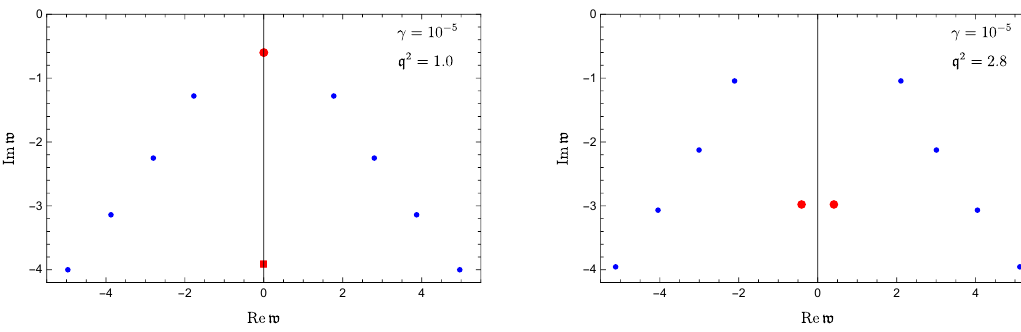
Figure 2 . Quasinormal spectrum in the shear channel of the N = 4 SYM for γ = 1 · 10 − 5 and q 2 = 1 (left panel). The hydrodynamic shear mode at w ≈ − 0 . 60064 i is shown by the red circle. The new feature, not seen in a perturbative calculation, is the appearance of an extra mode on the imaginary axis (shown by the red square), ascending from complex infinity with γ increasing [16]. With real q 2 increasing, the hydrodynamic mode moves down the imaginary axis, while the new non-perturbative mode moves up. They collide at q 2 ≈ 2 . 72 and move off the axis for q 2 > q 2 (right panel). ∗ ∗